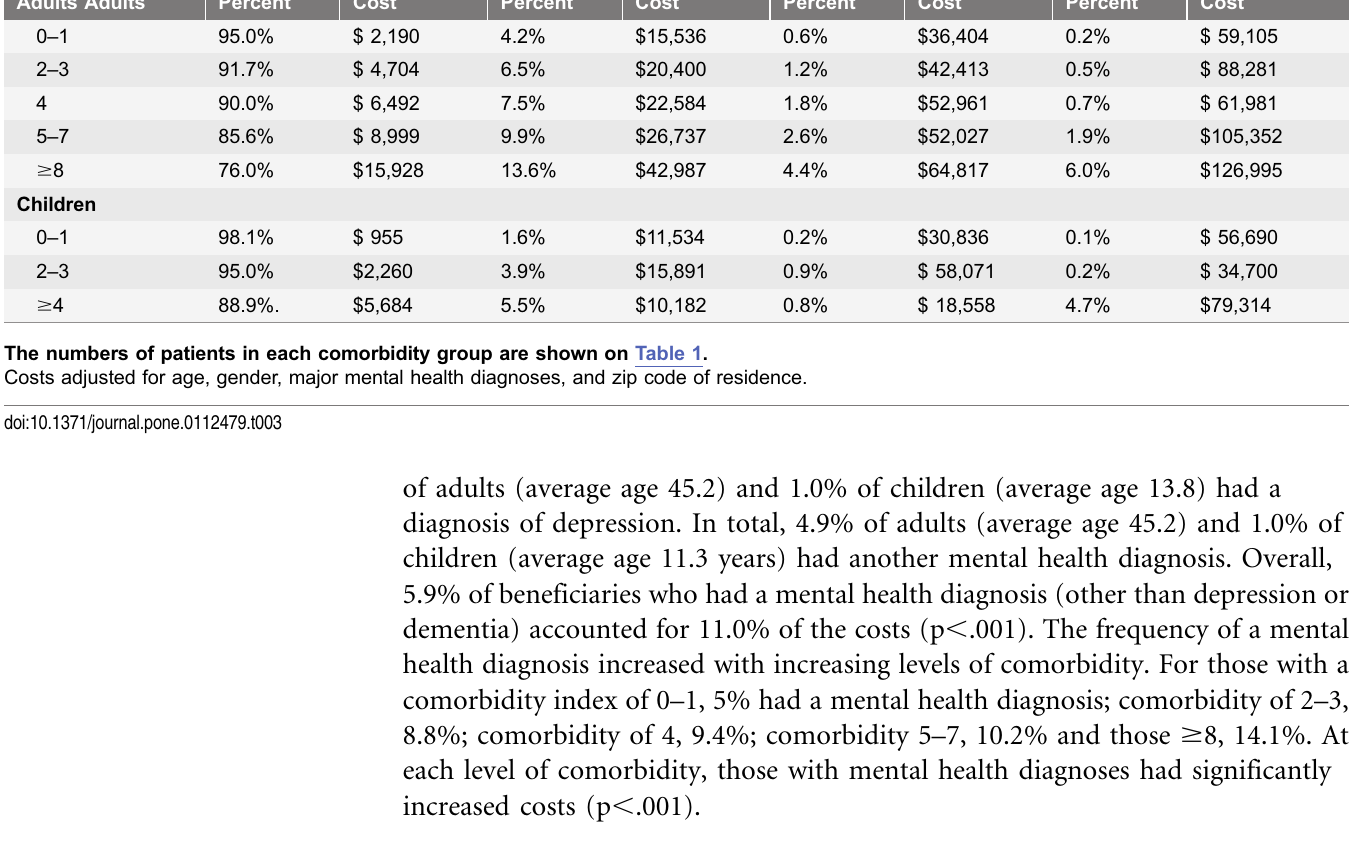
Table 3. Percent of beneficiaries according to 2010 hospitalizations and average 2010 yearly costs according to prior year comorbidity index.